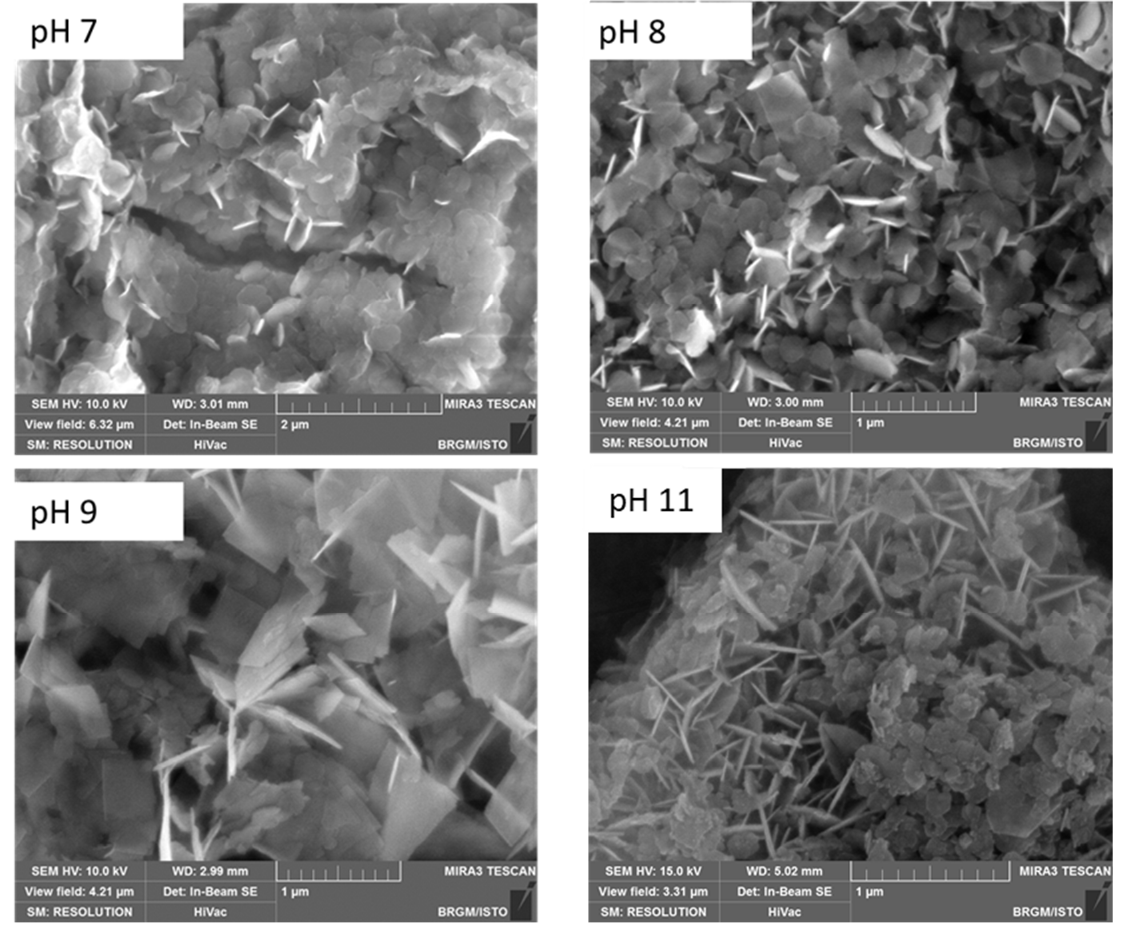
Figure 5. SEM images for Co/Fe LDHs synthesized at pH values 7, 8, 9 and 11. The Co/Fe compounds resulting from synthesis at pH values 7, 8, 9 and 11 are composed of agglomerated platelet particles presenting a pseudo-hexagonal shape. The hexagonal morphology of these particles is in good agreement with the usual morphology of LDH particles [78–80]. The particles show hexagon side lengths from 100 to 500 nm and thicknesses between 10 and 50 nm (Table